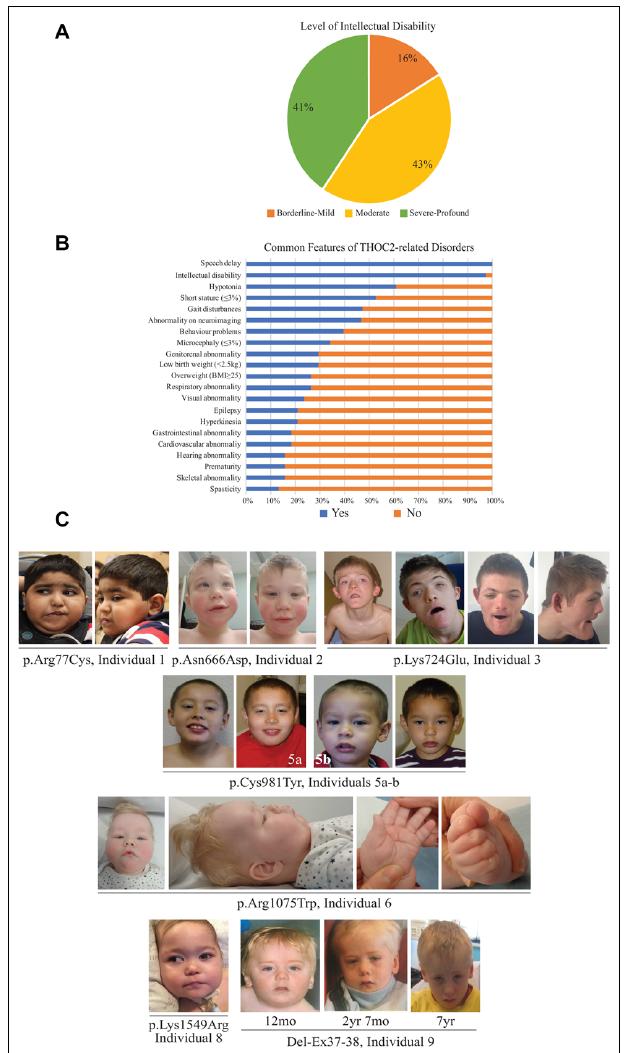
FIGURE 2 | Clinical presentations of the affected individuals identified so far. (A) Percentage of individuals with different levels of ID. (B) Percentage of individuals with common features. (C) Photographs of the affected individuals in the current